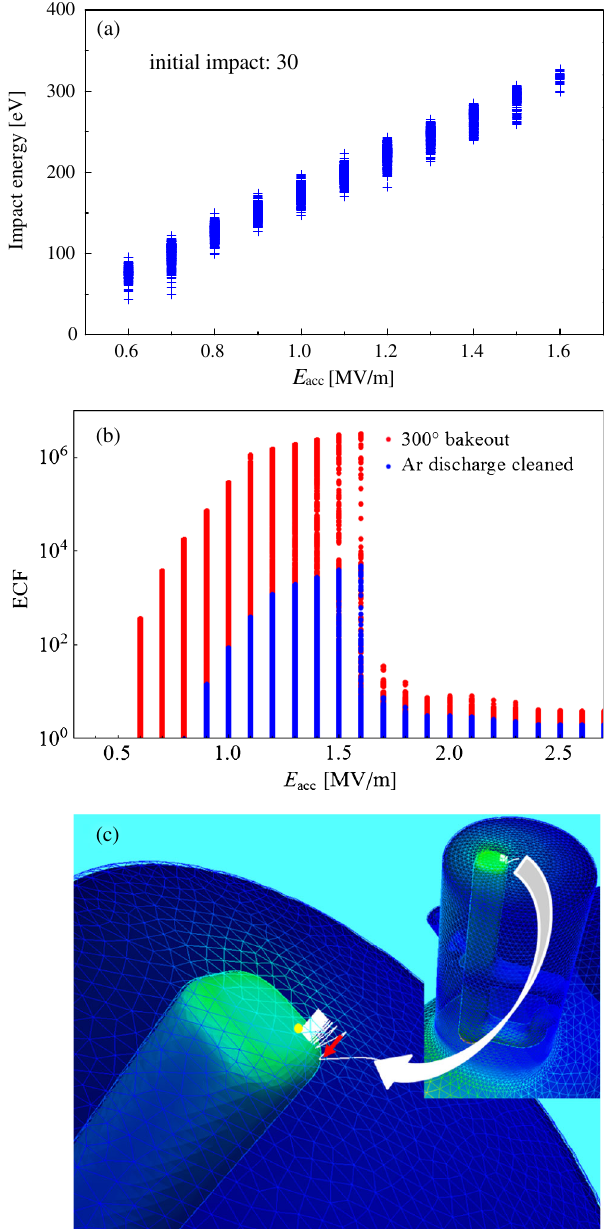
FIG. 5. Characteristics of zone 1 MP: (a) electron impact energy; (b) enhancement counter function after impacting for 20 rf periods; (c) typical electron trajectory. The emission site is indicated by the yellow dot. The movement direction of the MP electron is indicated by red arrows. Finally, the emission electron slips out of the square area of the inner conductor.